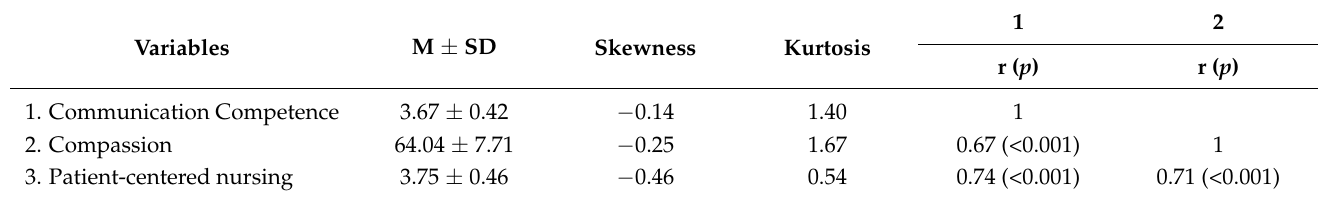
Table 2. Correlation among shared decision-making, compassion, and patient-centered care ( N = 204).